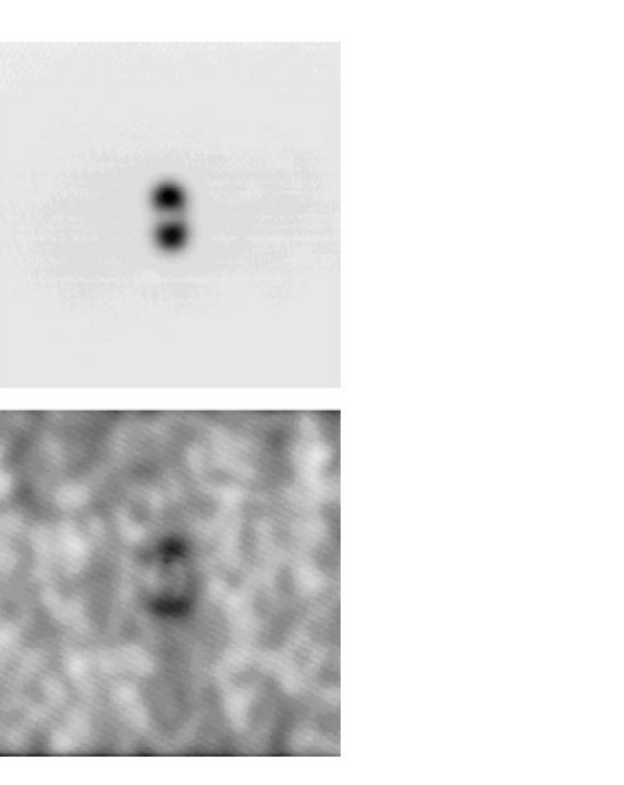
Figure 15. Eddy current images of small fatigue cracks in 2024 aluminum and Ti-6Al-4V